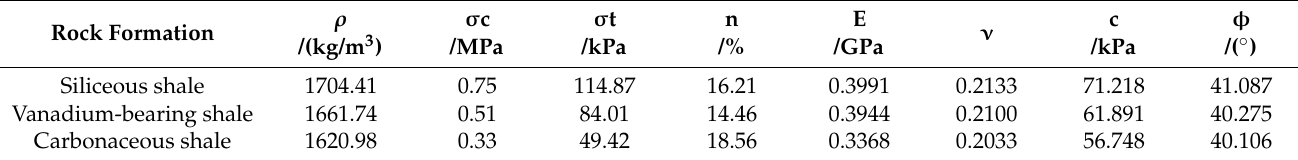
Table 11. Similar material selection and mechanical parameters.